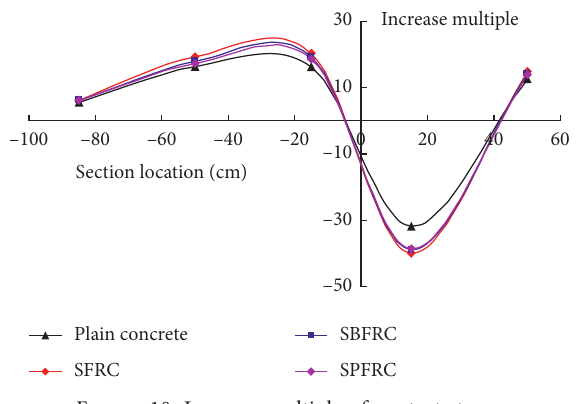
Figure 10: Increase multiple of contact stress. Table 10: Increase percentage of maximum value of increase multiple of contact stress.